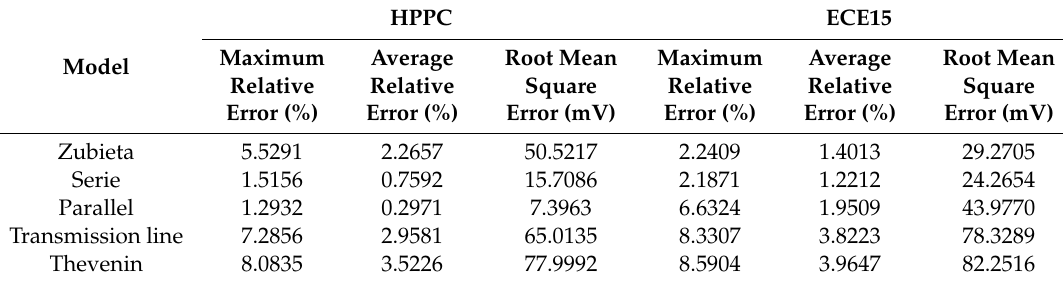
Table 5. The statistical metric with Current Profile i 2 .